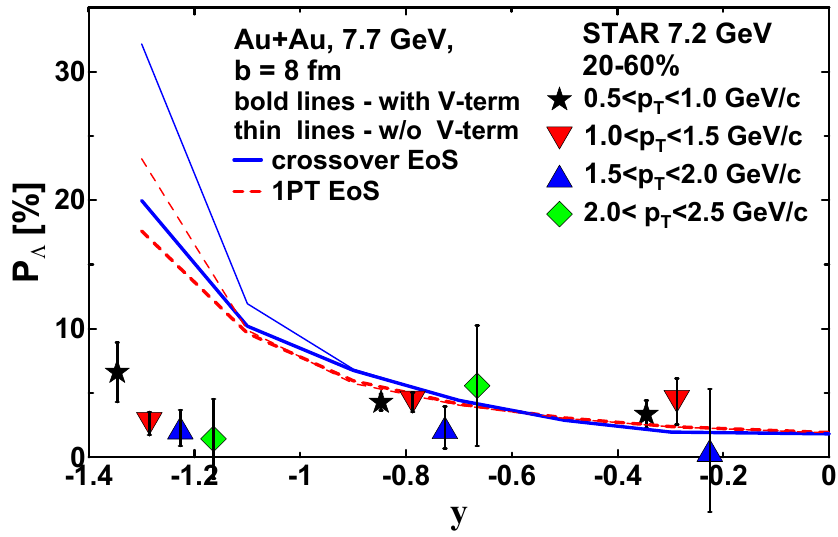
√ s NN = 7.7 GeV Figure 2. Rapidity dependence of the global Λ polarization in Au+Au collisions at ( b = 8 fm), originating from only the thermal vorticity (thin lines) and the one with the additional vector–meson contribution (bold lines). The results for different EoSs are presented. Preliminary √ s NN = 7.2 GeV and centrality 20–60% are from Ref. [36]. STAR data for Au+Au collisions at